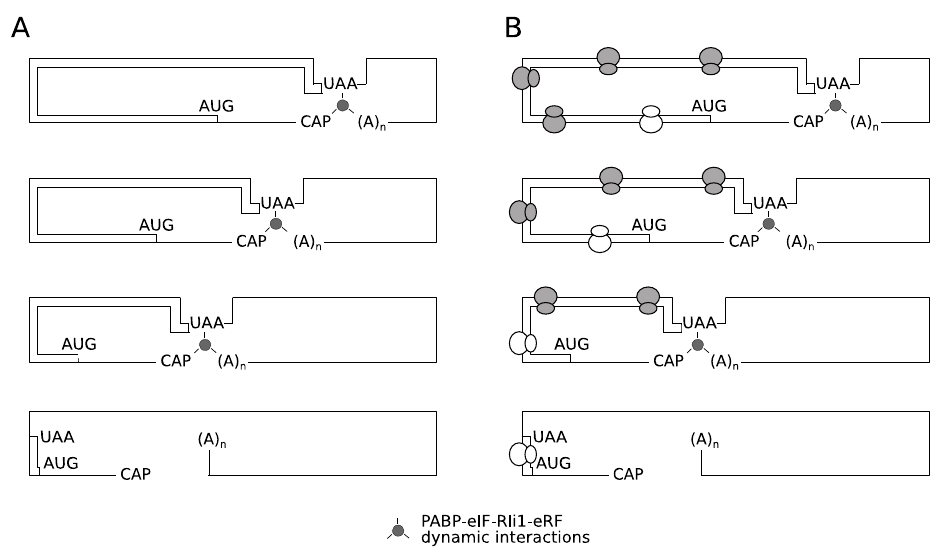
Figure 8. A spatio-mechanical model and temporal-biochemical model of PTC position effects on non-NMD instability. Two models for the effects of an early (codon 22) stop codon on the stability of an mRNA. Assuming an absence of a nonsense-mediated decay apparatus, in panel A , spatio-mechanical constraints limit the ability of the terminating release factor-rRli1 recycling factor complex to interact with a closed-loop eIF-PABp complex, thus destabilizing the mRNA. An alternative model is presented in panel B ; ribosomes translating immediately post-initiation are not competent to either recycle on the same mRNA following termination, or in some way to promote mRNA stabilization during the course of the normal elongation/termination cycle. That stabilization property is acquired over the course of a number of translation elongation cycles, allowing ribosomes that have terminated at more 3 ′ stop codons to promote mRNA stabilization, while termination at early (e.g., codon 22) termination codons cannot impart stability.